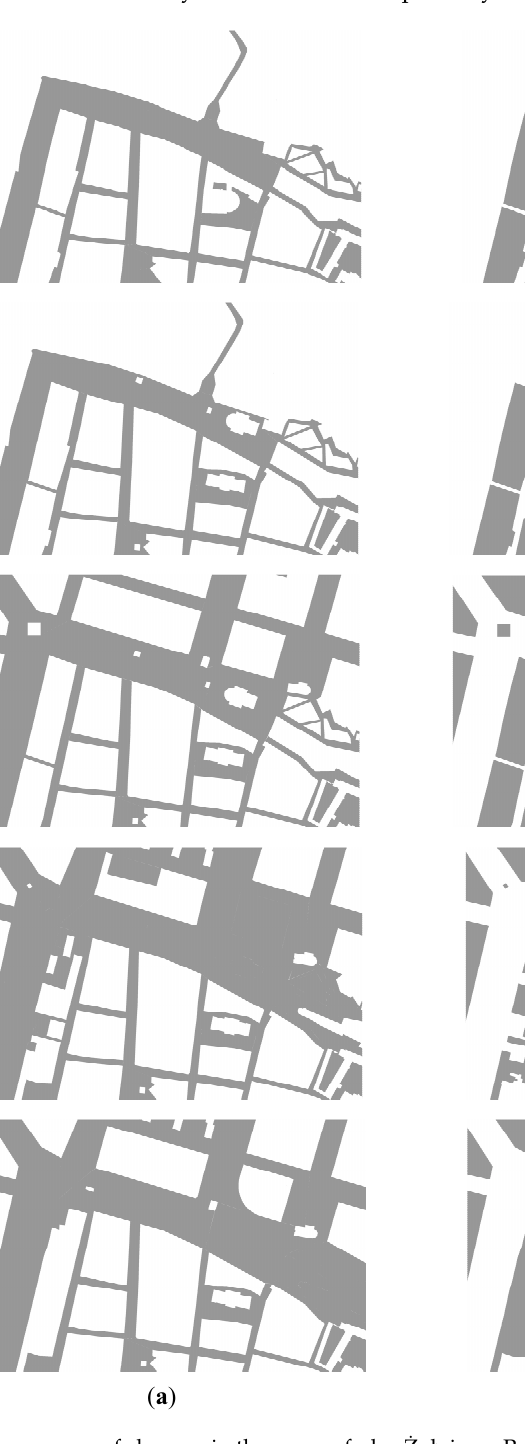
Figure 6. The process of changes in the space of plac ˙Zołnierza Polskiego and plac Solidarno´sci in Szczecin. The division of the spatial structure of the city: ( a ) convex structure (source: created by author I. Kozłowska); ( b ) concave structure (source: created by